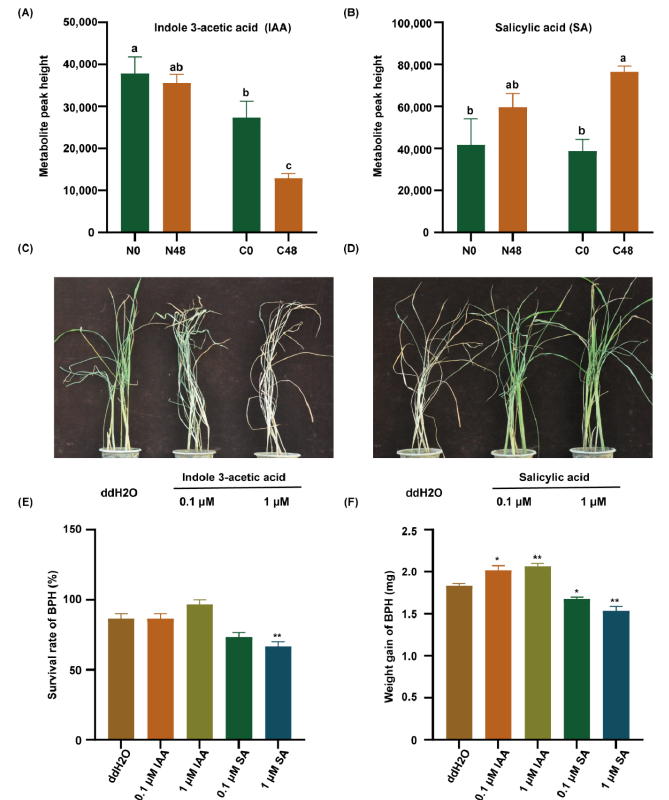
Figure 5. Indole 3-acetic acid (IAA) and salicylic acid (SA) regulate BPH resistance in rice. ( A ) The content of IAA in rice leaf sheath. ( B )The content of SA in rice leaf sheath. Different lowercase letters above the bars indicate significant differences ( p < 0.05 by one-way ANOVA with LSD’s post-hoc test), all data were presented as the mean value ± SE(A,B). ( C ) A representative image of the Nipponbare plants after pre-treatment with ddH2O, 0.1 µM IAA, or 1 µM IAA applied to plant leaf sheaths for 2 h followed by 10 third-instar BPH nymphs per plant for 6 days. ( D ) A representative image of the Nipponbare plants after pre-treatment with ddH2O, 0.1 µM SA, or 1 µM SA applied to plant leaf sheaths for 2 h followed by 10 third-instar BPH nymphs per plant infestation for 8 days. ( E ) The survival rate of BPH fed on Nipponbare plants pre-treatment with ddH2O, 0.1 µM IAA, 1 µM IAA, 0.1 µM SA, or 1 µM SA applied to 1/2 MS for 7 days followed by female BPH adult infestation for 48 h. ( F ) Statistical analyses of weight gain of BPH fed on Nipponbare plants pre-treatment with ddH2O, 0.1-µM IAA, 1 µM IAA, 0.1 µM SA, or 1 µM SA applied to 1/2 MS for 7 days followed by female BPH adult infestation for 48 h. Three replicates were used for analysis ( A , B , E , F ). The asterisk represented a significant difference between the treatment and the control—*, p < 0.05; **, p < 0.01 by one-way ANOVA with Dunnett’s post-hoc test ( E , F ). All data were presented as the mean value ± SE.